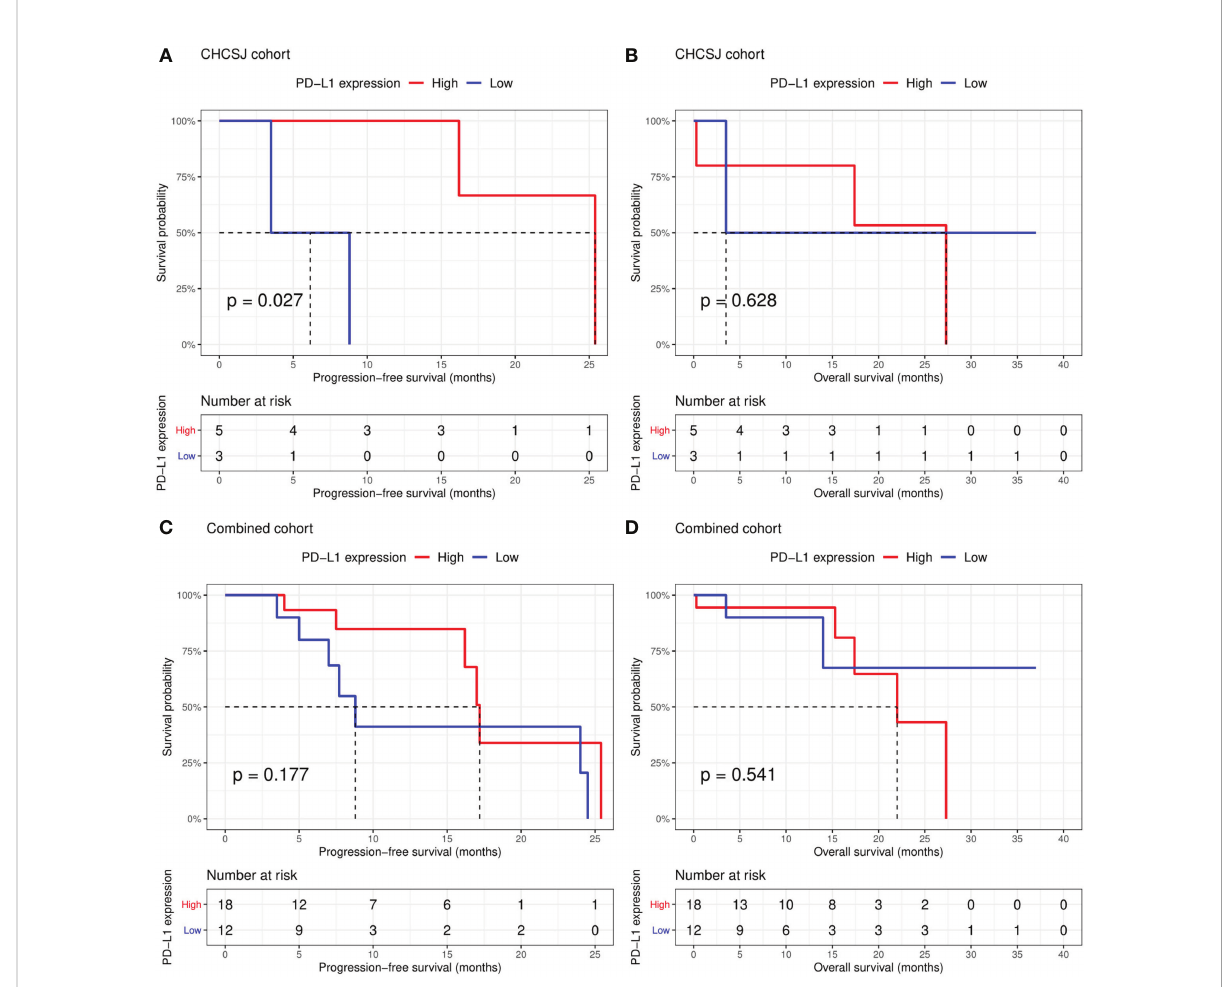
FIGURE 3 Comparison of progression-free survival (A, C) and overall survival (B, D) between patients with high (TPS ≥ 30%) and low (TPS <30%) PD-L1 expression in the CHCSJ and combined cohorts. TPS, tumor proportion score.